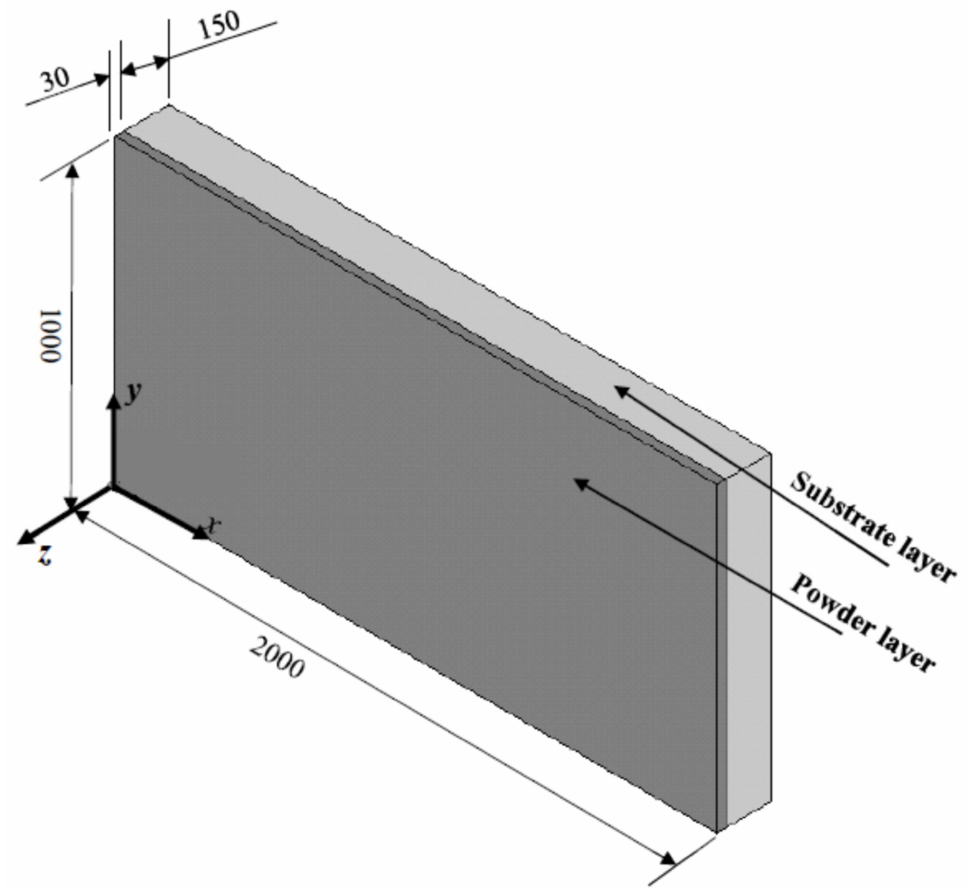
Figure 4. Geometric model used in the present analysis (all dimensions are in µ